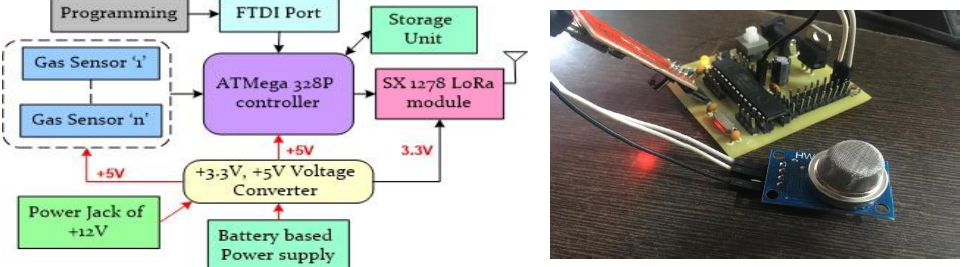
Figure 9. Sensor Figure 9. Sensor nodes. Table 2. SX 1278 Long-Range specifications [31].